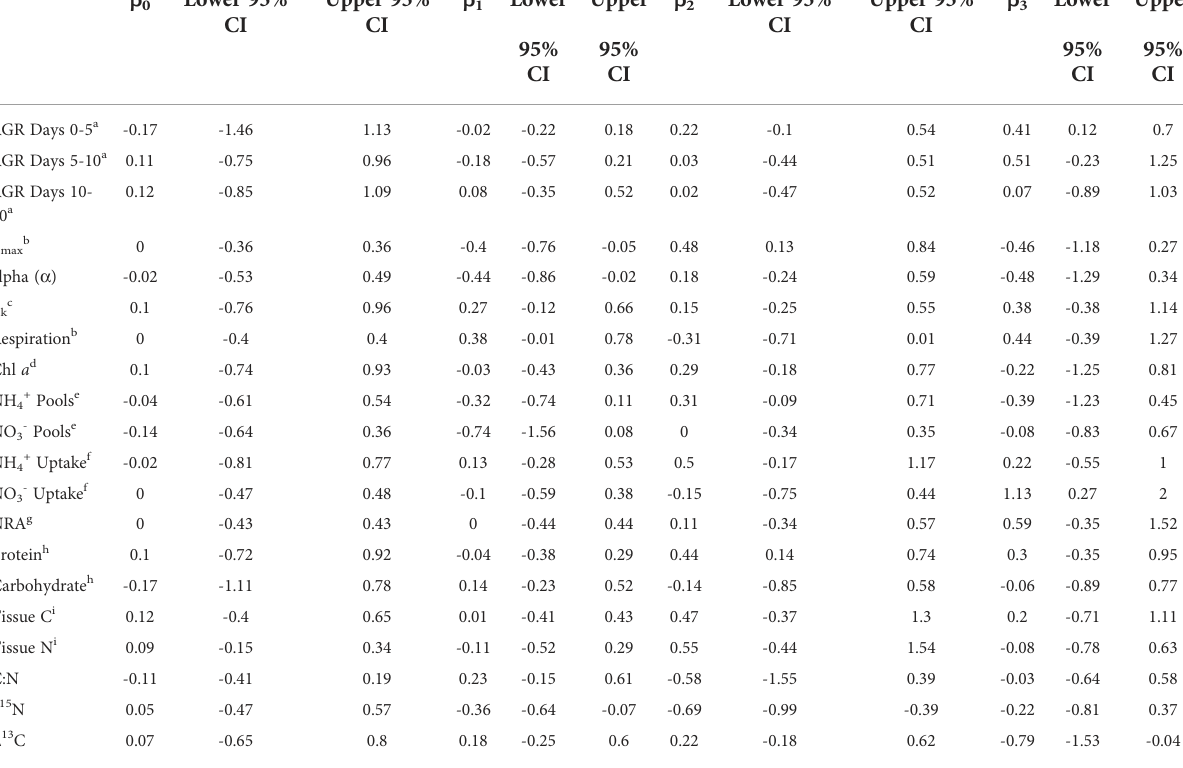
TABLE 1 Weighted, model-averaged estimates of standardized regression coef fi cients and 95% con fi dence interval (CI) for each experimental